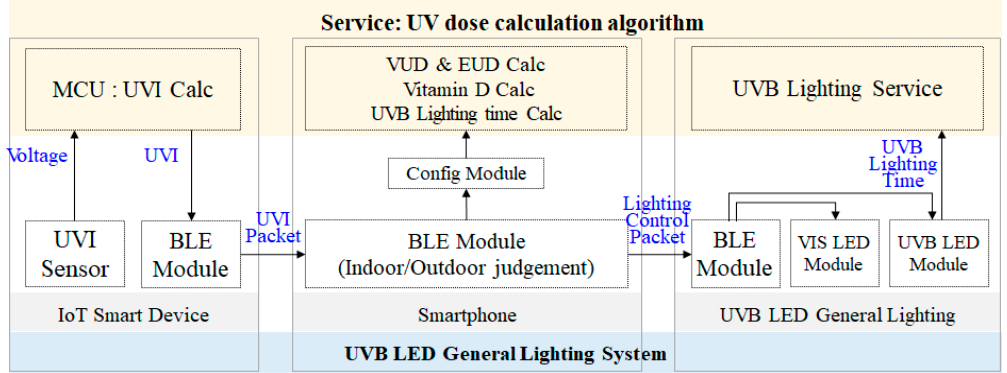
Figure 2. Construction of UVB general lighting system.